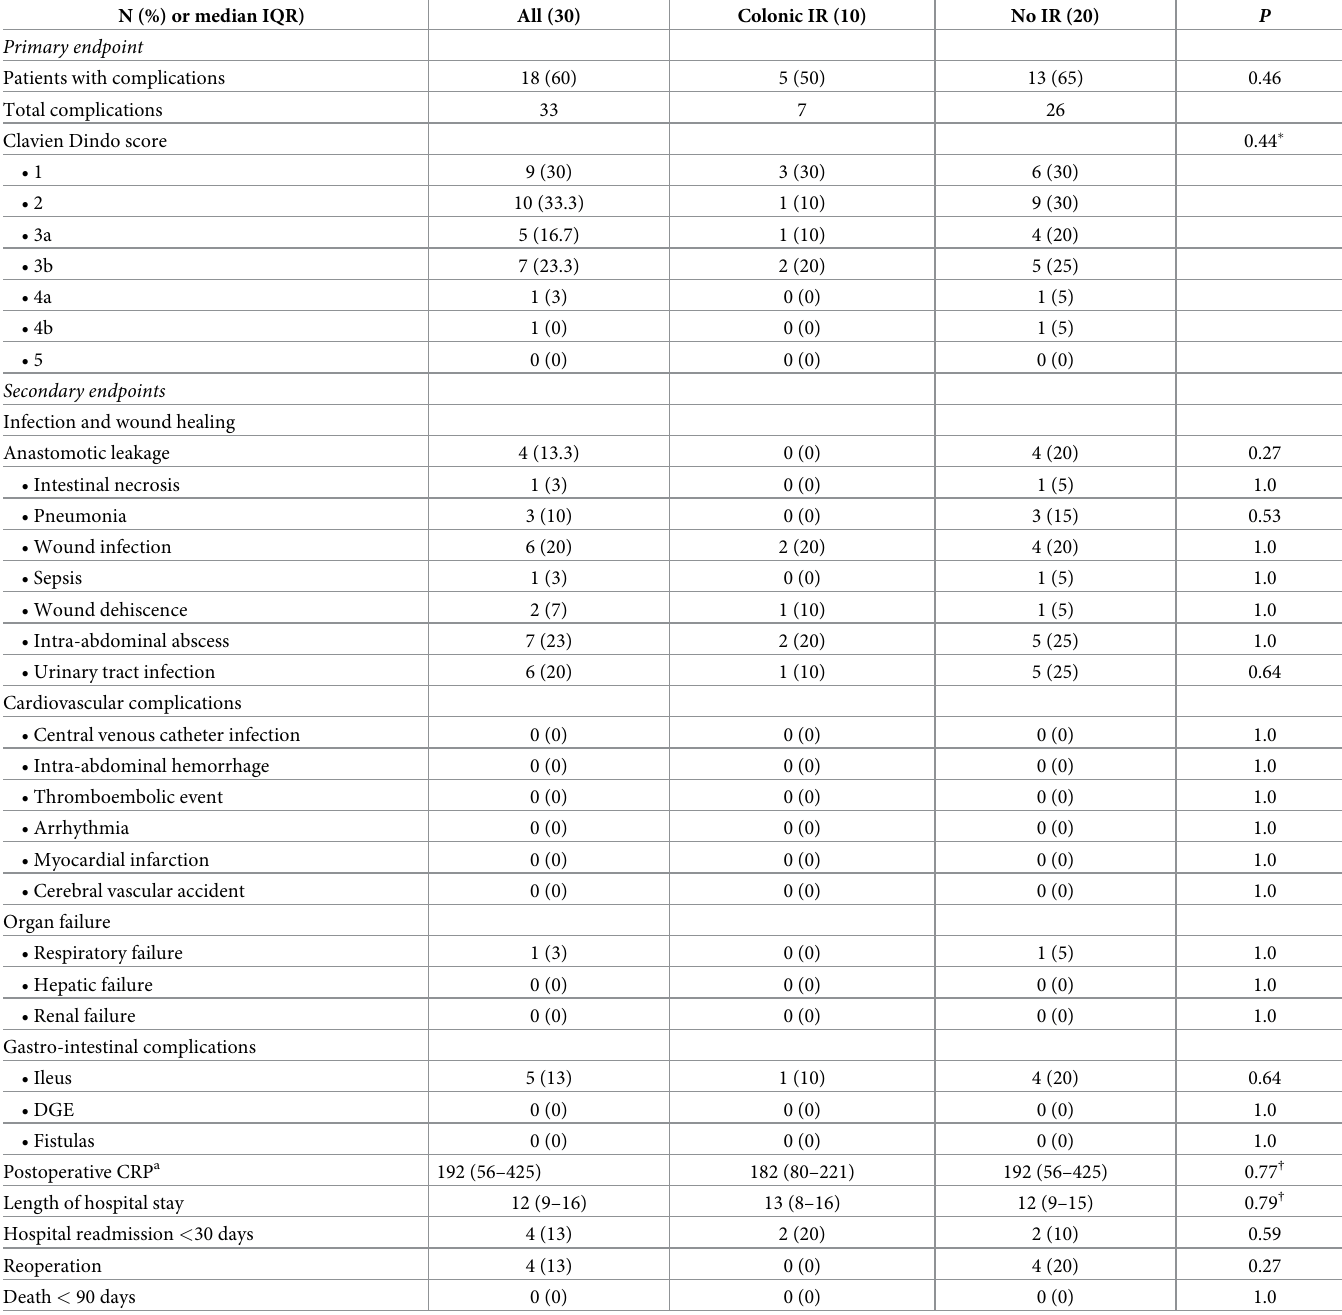
Table 4. Morbidity and mortality of patients undergoing colorectal surgery with and without experimental in vivo colonic IR. N (%) or median